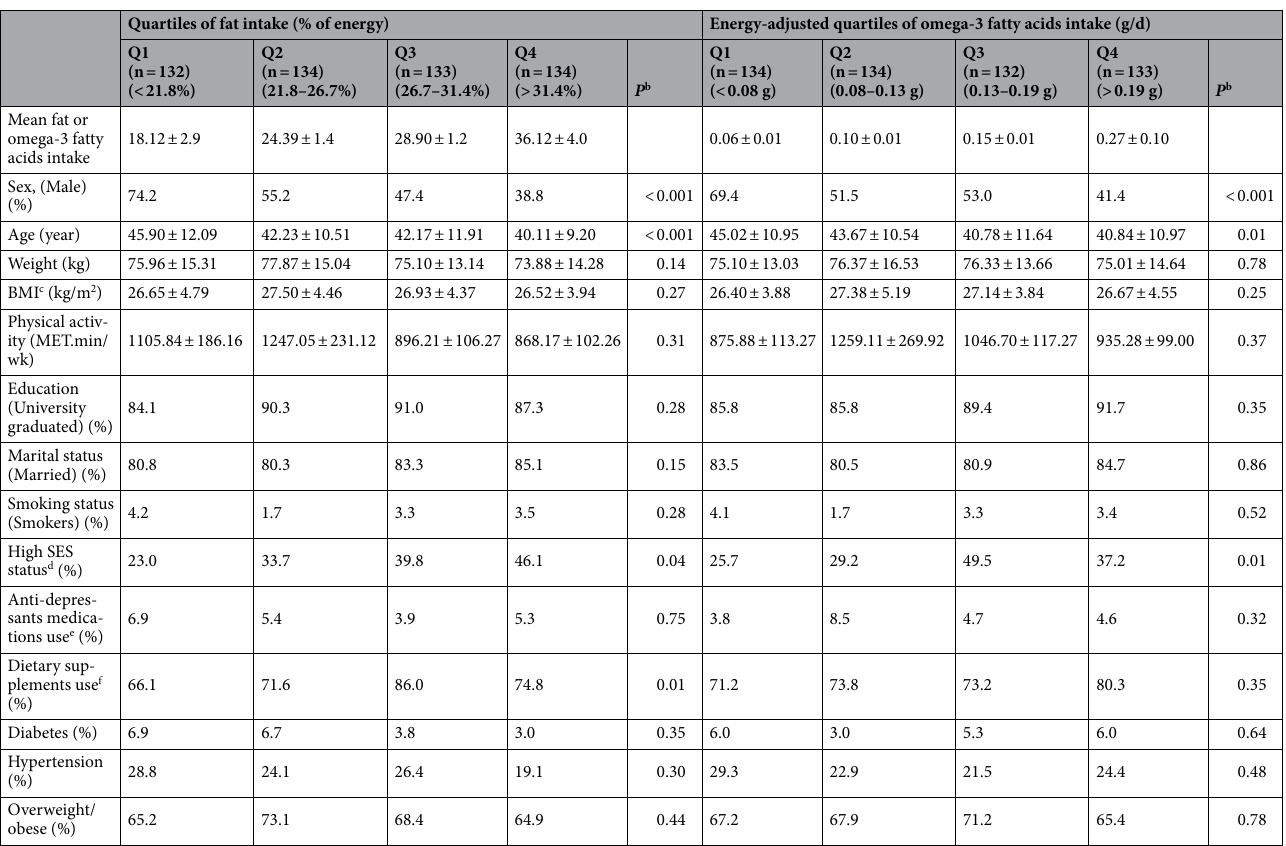
Table 1. General characteristics of study participants across quartiles of fat (as percentage of energy intake) and energy-adjusted omega-3 fatty acids intake a . a Continuous variables are reported as mean ± SD, except for physical activity that is reported as mean ± SE. Categorical variables are reported as percentage. b P -values obtained from ANOVA and χ 2 test for continuous and categorical variables, respectively. c BMI: Body Mass Index. d Socioeconomic status (SES) status was evaluated based on job, number of family members (more than 4 vs. 4 or less), head of household, the job of the household head, home ownership status, type of house, number of family cars, type of car, number of laptops, number of travels (within the country or abroad),